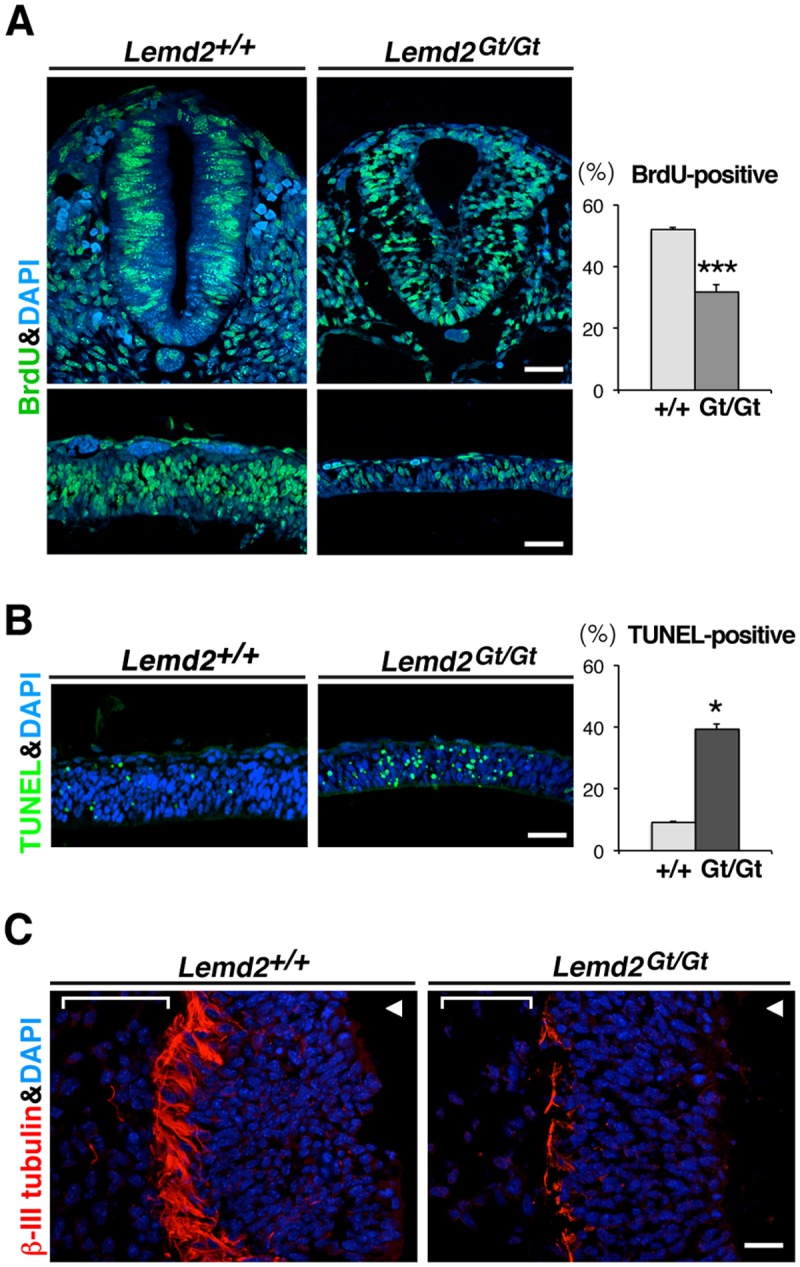
Increased apoptosis, reduced cell proliferation and smaller number of differentiated neurons in the absence of Lem2.(A) Cell proliferation monitored by BrdU incorporation in Lemd2
+/+ and Lemd2
Gt/Gt embryos at E10.5. Anti-BrdU staining (green) with DAPI counterstaining (blue) of cryosections of the neural tube, showing transverse (upper panels, posterior region) and sagittal (lower panels, midbrain region) views. Bar graph: Quantification of the percentage of BrdU-positive cells in the neuroepithelium of Lemd2
+/+ and Lemd2
Gt/Gt E10.5 embryos. (B) Midbrain sections adjacent to those of Fig. 5A (lower panels) subjected to terminal dUTP nick end labeling (TUNEL) analysis (green) and DAPI counterstaining (blue). Bar graph: Quantification of the percentage of TUNEL-positive cells in the midbrain of Lemd2
+/+ and Lemd2
Gt/Gt E10.5 embryos. (C) Immunofluorescence staining of class III β-tubulin (red) and DAPI counterstaining (blue) in the hindbrain neuroepithelium of wild-type and Lemd2
Gt/Gt embryos at E10.5. Arrowheads point to the ventricular surface of the neuroepithelium, and brackets indicate the layer of mesenchyme. Data are presented as mean ± SD. (*p < 0.0005, *** p < 0.05). Bars: 50 μm.